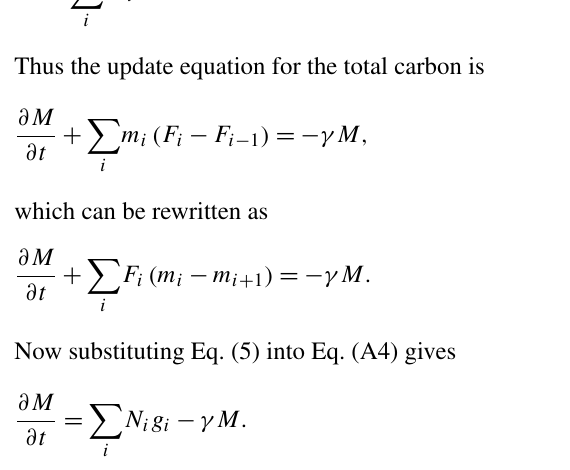
Figure B1. The quasi-Weibull number density solution to DET (Eq. B1), assuming the same initial n 0 and growth scaling φ g = 0 . 75 but different µ 0